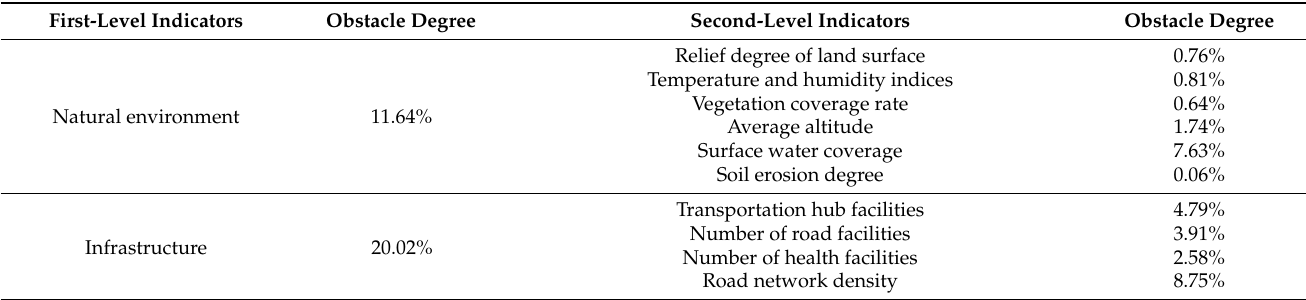
Table 4. Obstacle degree against human settlement quality for the whole Qinghai–Tibet